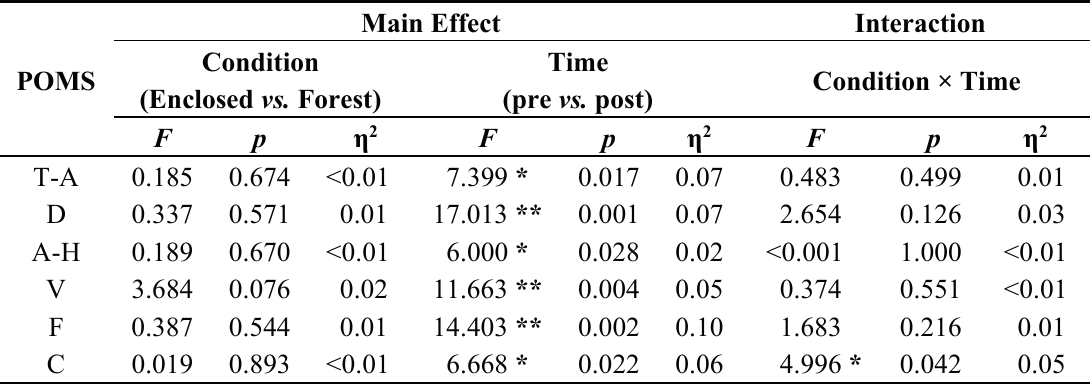
Table 7. Results of the two-way repeated measures ANOVA of POMS